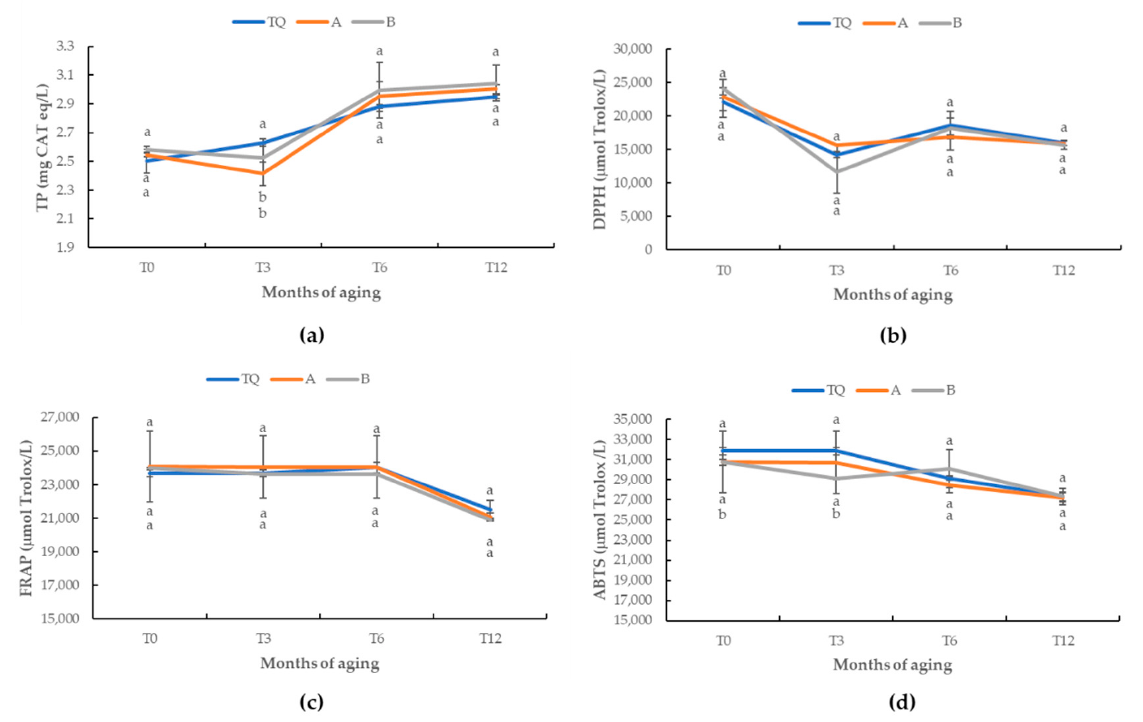
Figure 1. Evolution of antioxidant activity during the aging period (12 months) in the wine treated with different stabilizing products: ( a ) total phenols (TP); ( b ) DPPH values; ( c ) FRAP values; ( d ) ABTS values. Treatments: TQ (SO2); A (UGE, 200 mg/L and chitosan); B (UGE, 400 mg/L). Different letters indicate significant differences among the samples according to the Tukey’s least significative difference (LSD) test.